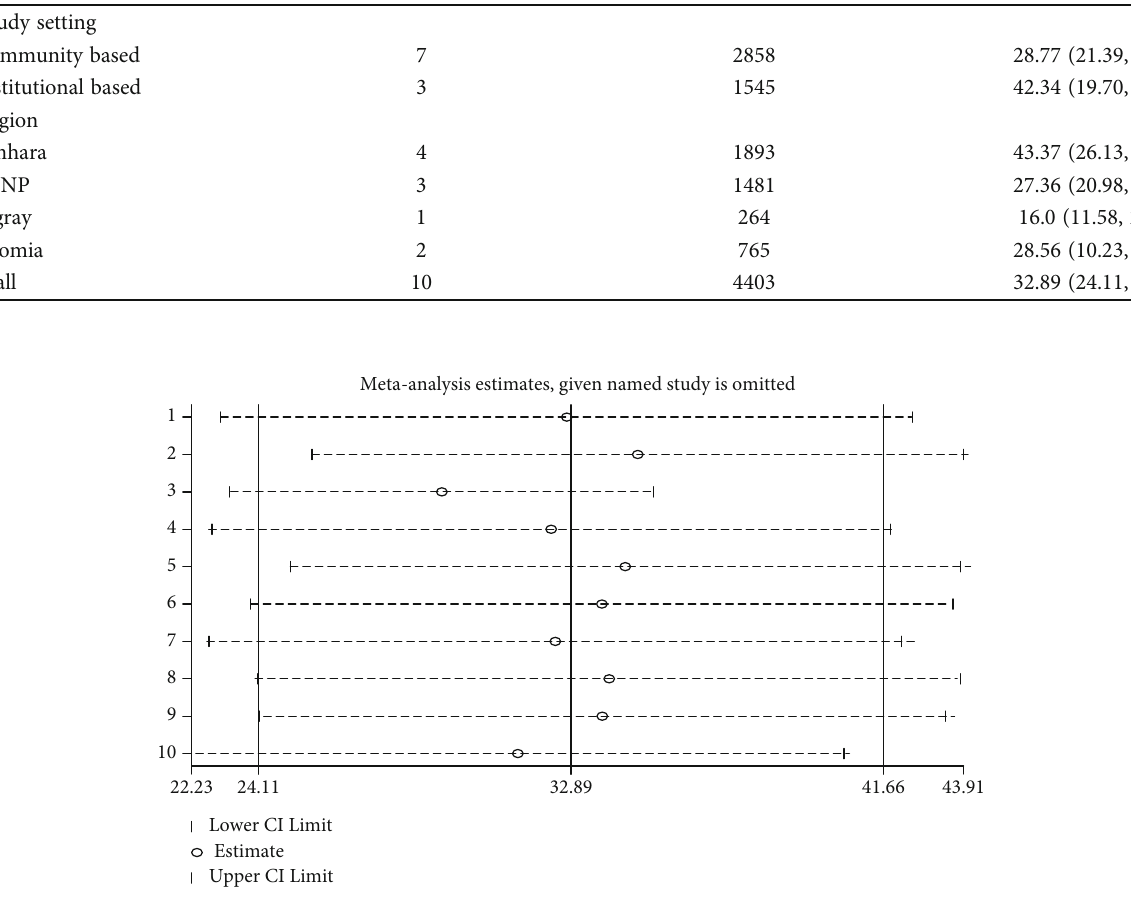
Table 2: Subgroup analysis for the prevalence of Implanon discontinuation among reproductive age women in Ethiopia ( n = 10 ). Variables